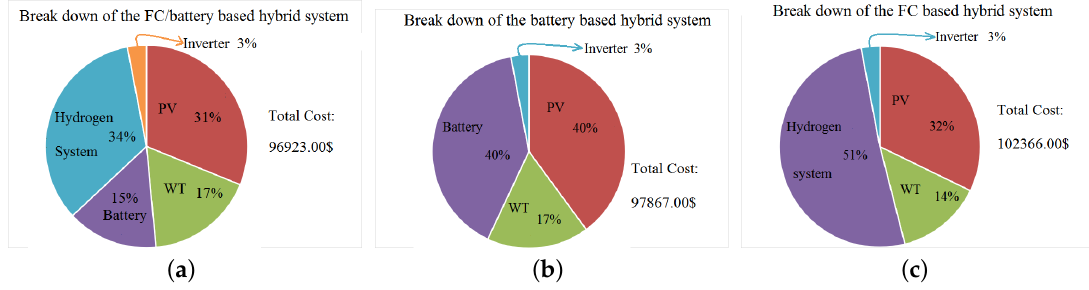
Figure 12. Comparison of three kinds of hybrid power systems. ( a ) Breakdown of the fuel cell (FC)/battery-based hybrid system; ( b ) breakdown of the battery-based hybrid system; and ( c ) breakdown of the FC-based hybrid